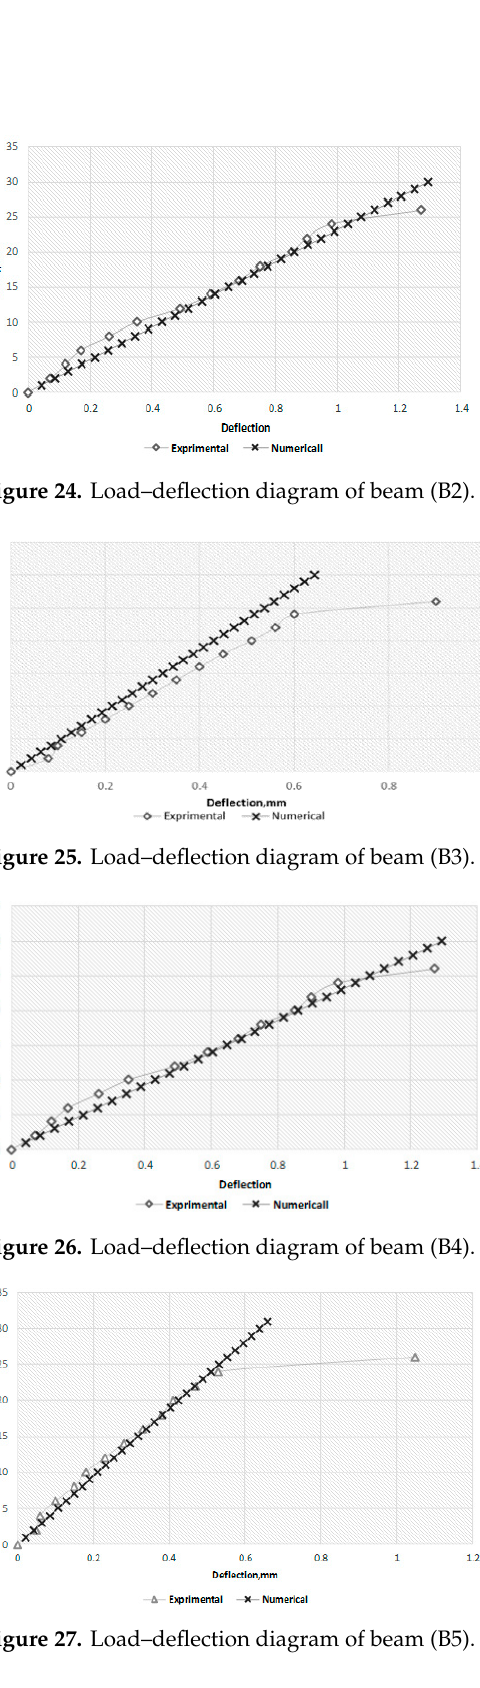
Figure 27. Load–deflection diagram of beam (B5).